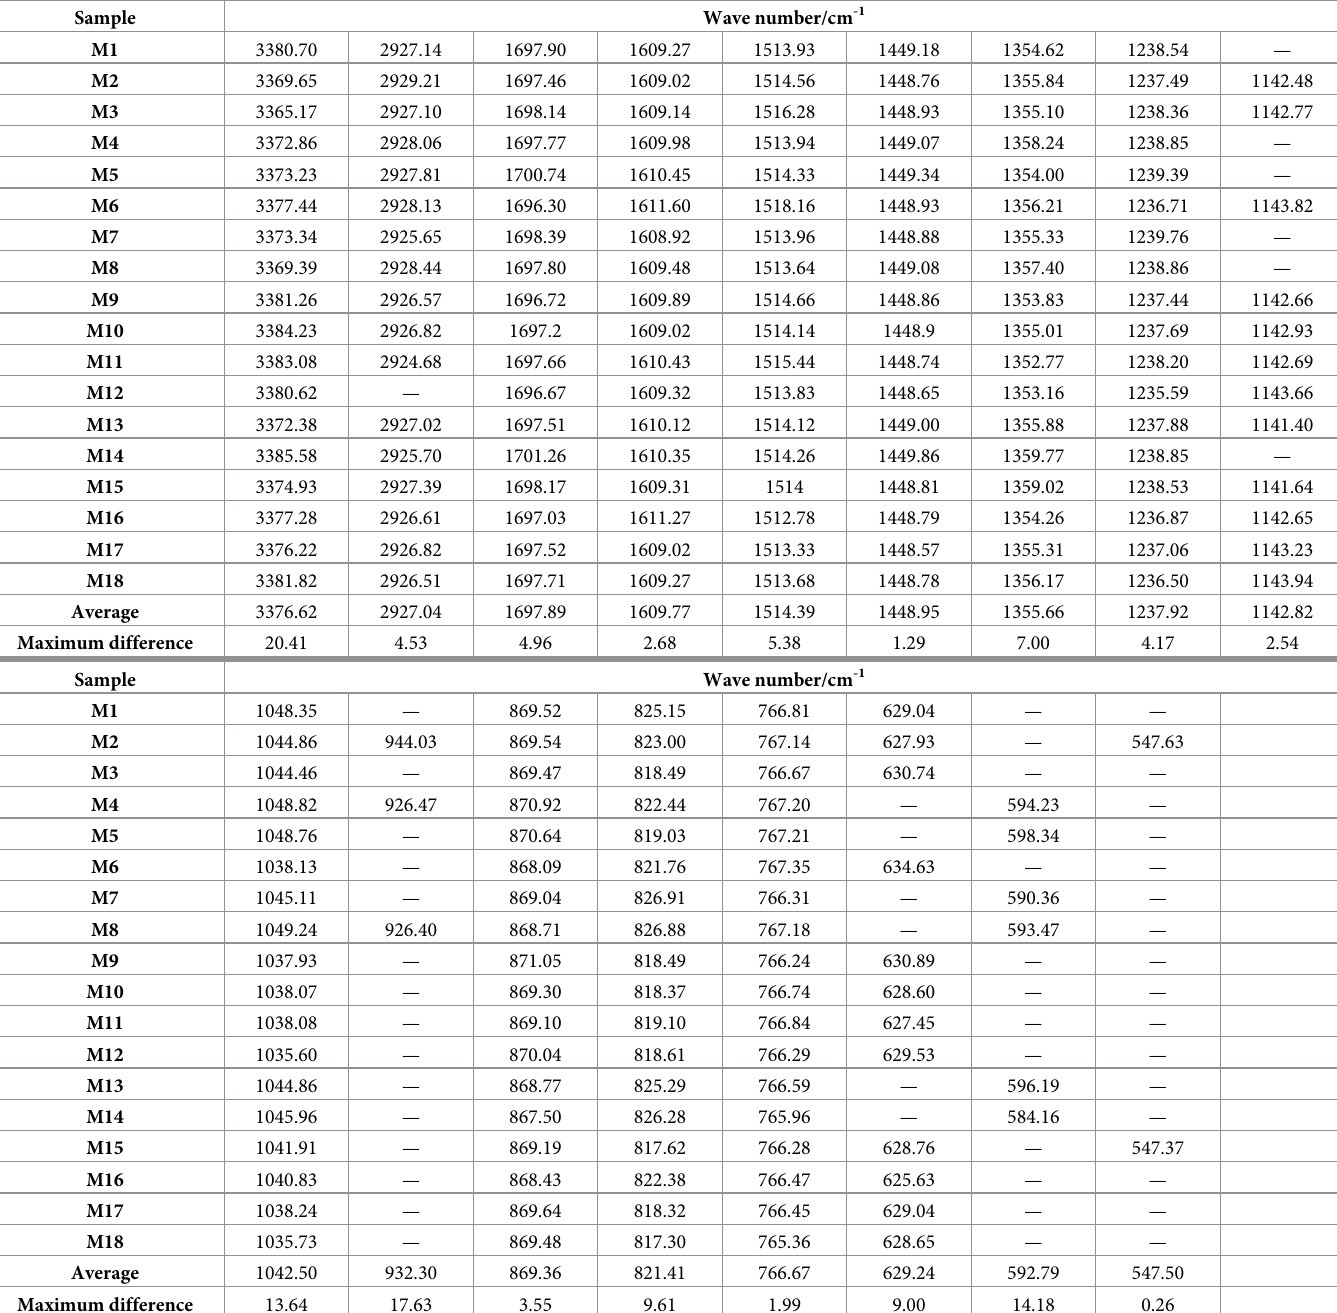
Table 3. Common peaks of M1~M18 FTIR absorption.